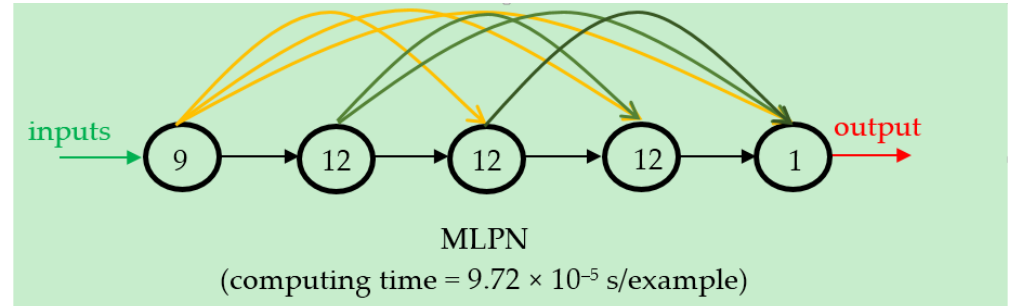
11 of 26 Table 6. For best combo of each SA: F methods used. SA